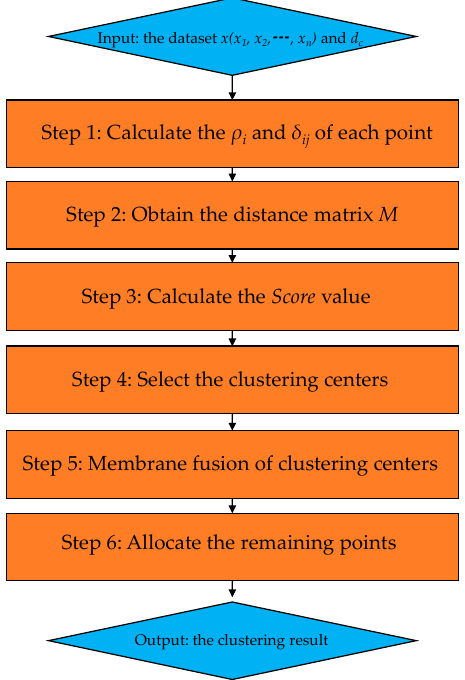
Figure 3. The workflow of the TP-DSDPC algorithm.